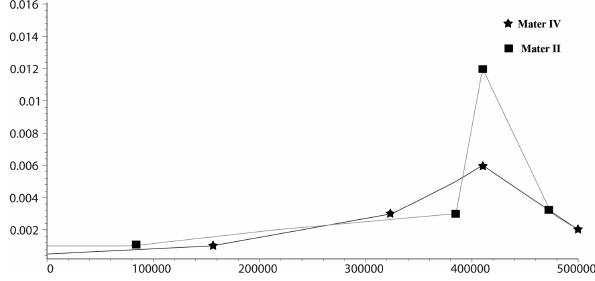
Figure 8. Variations in χ ∗ , defined as K ∗ → K ∗ + χ ∗ (ξ) , along ξ (m), obtained through optimizing the balance of Eq.